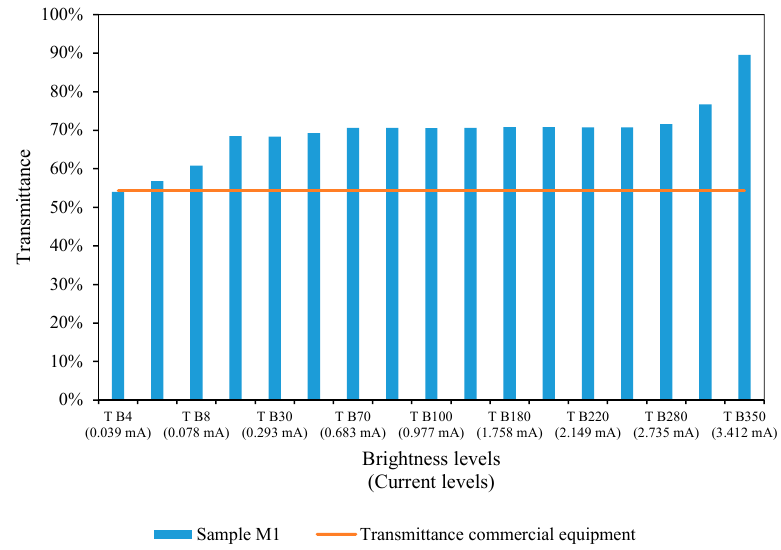
Figure 8. Effects of the brightness level in the transmittance measurement, using a 385 nm LED [30] on Sample M1.